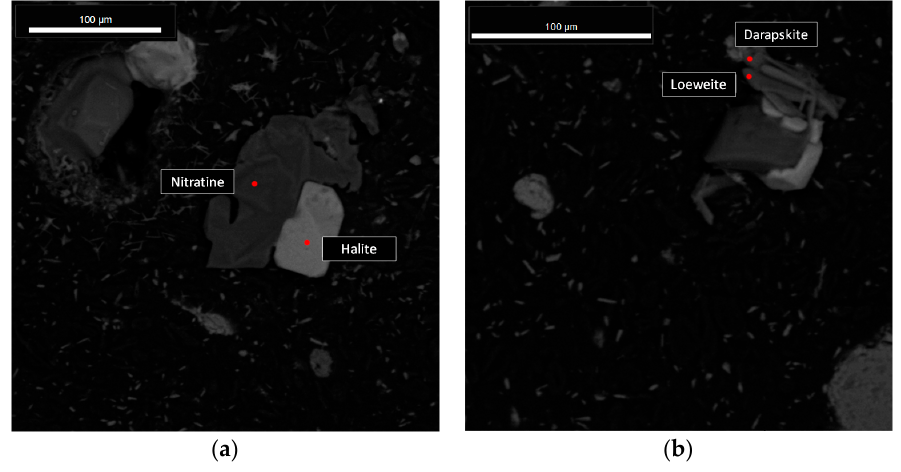
Figure 2. Backscattered electron image (BSE) of samples with ( a ) Nitratine–Halite and ( b ) Darapskite–Loeweite associations. Spectrograms of the species are presented in Figures A1 and A2 (Appendix A) and the measure points of figures are denoted in the figure as dots.